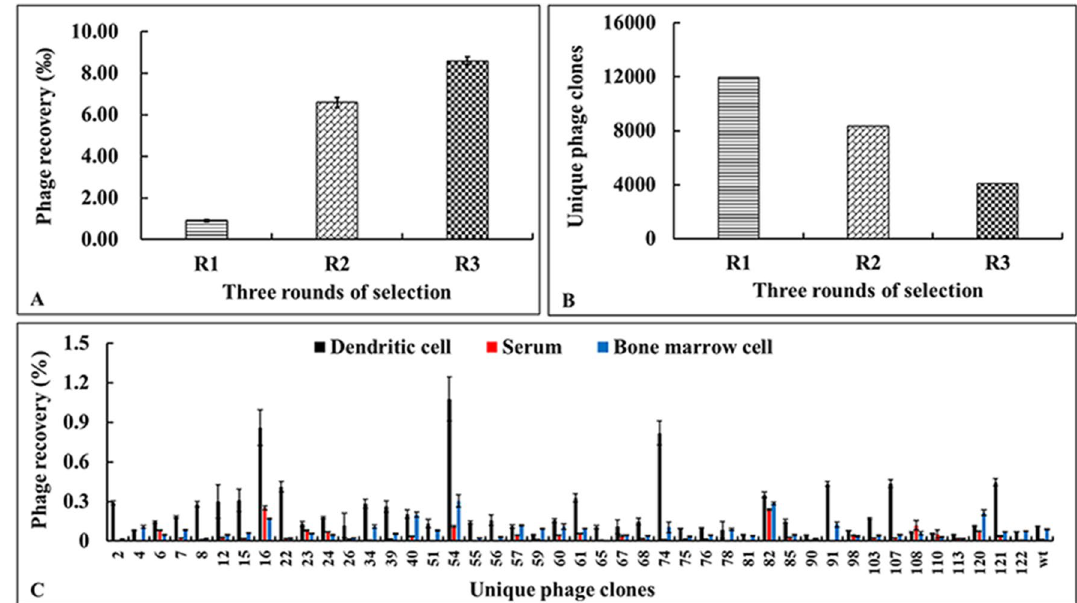
Figure 3. Phage recovery measurement and unique phage clone analysis of the eluates of each round of bio-panning. ( A ) Phage recovery was calculated as the ratio of recovered phage versus the input phage as follows: phage yields (%) = (output phage/input phage) × 100. ( B ) The VHH gene in the eluate of each round of bio-panning was amplified and the unique VHH gene sequence analyzed by next-generation sequencing. ( C ) Specificity assay of 46 unique sequence phage clones. The specificity of unique sequence phage (black) towards chicken dendritic cell in comparison with chicken bone marrow cell (blue) and serum (red) is